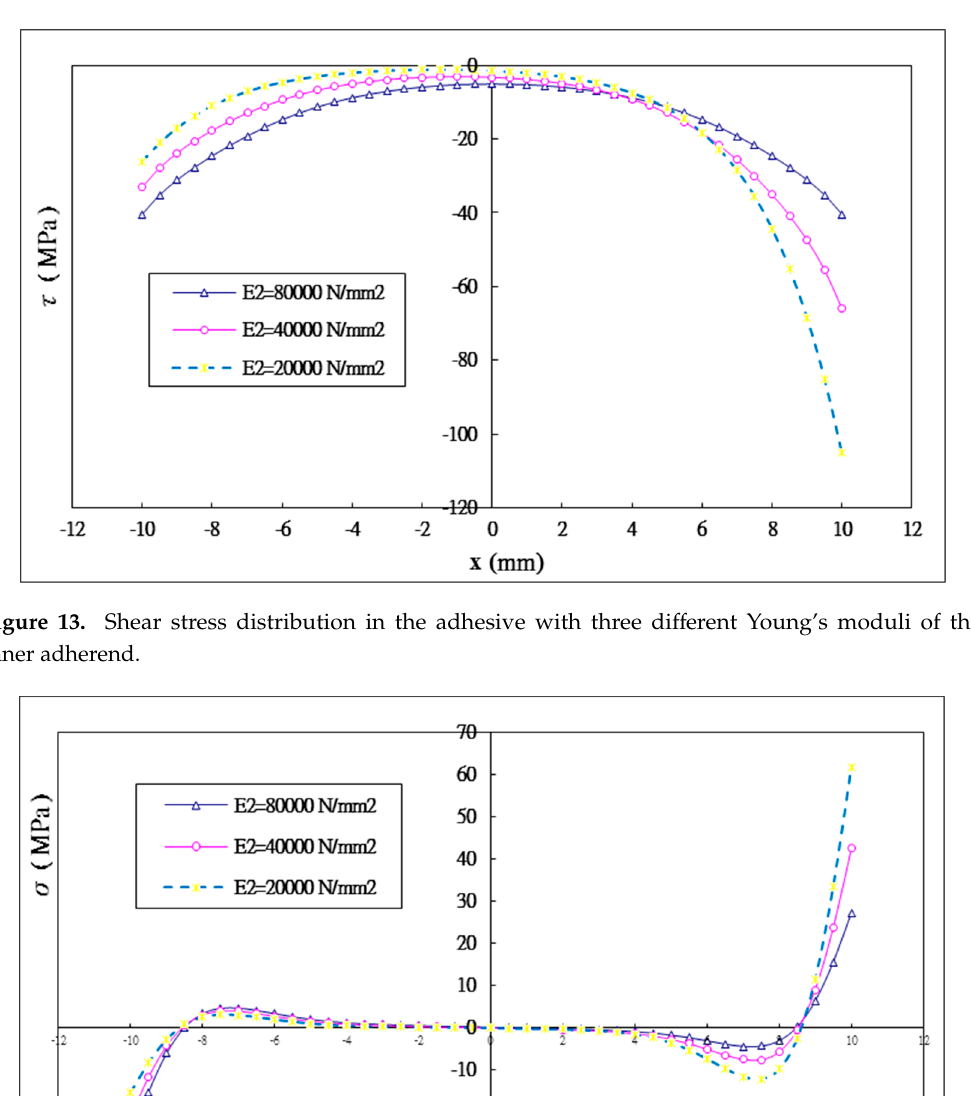
Table 6. Comparison of maximum interfacial stresses with different inner adherend Young’s modulus obtained by Equation (44) and ANSYS.